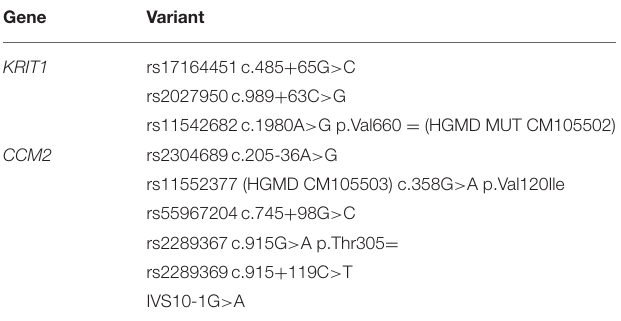
TABLE 1 | Variants detected in the 84-years old woman affected by familial CCM.